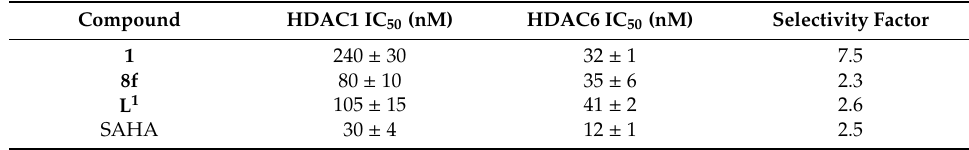
Table 1. IC 50 values measured for selected compounds against HDAC1 and HDAC6. Selectivity factor defined as ratio of the two IC 50 values. All assays carried out in triplicate. See Supplementary Materials for details.